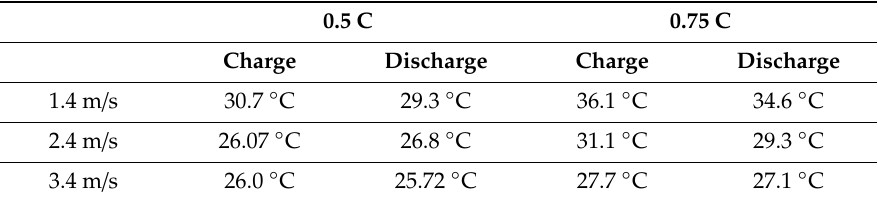
Table 5. Disparities in Maximum Temperature of Cell 12 during Charge/Discharge Cycle.